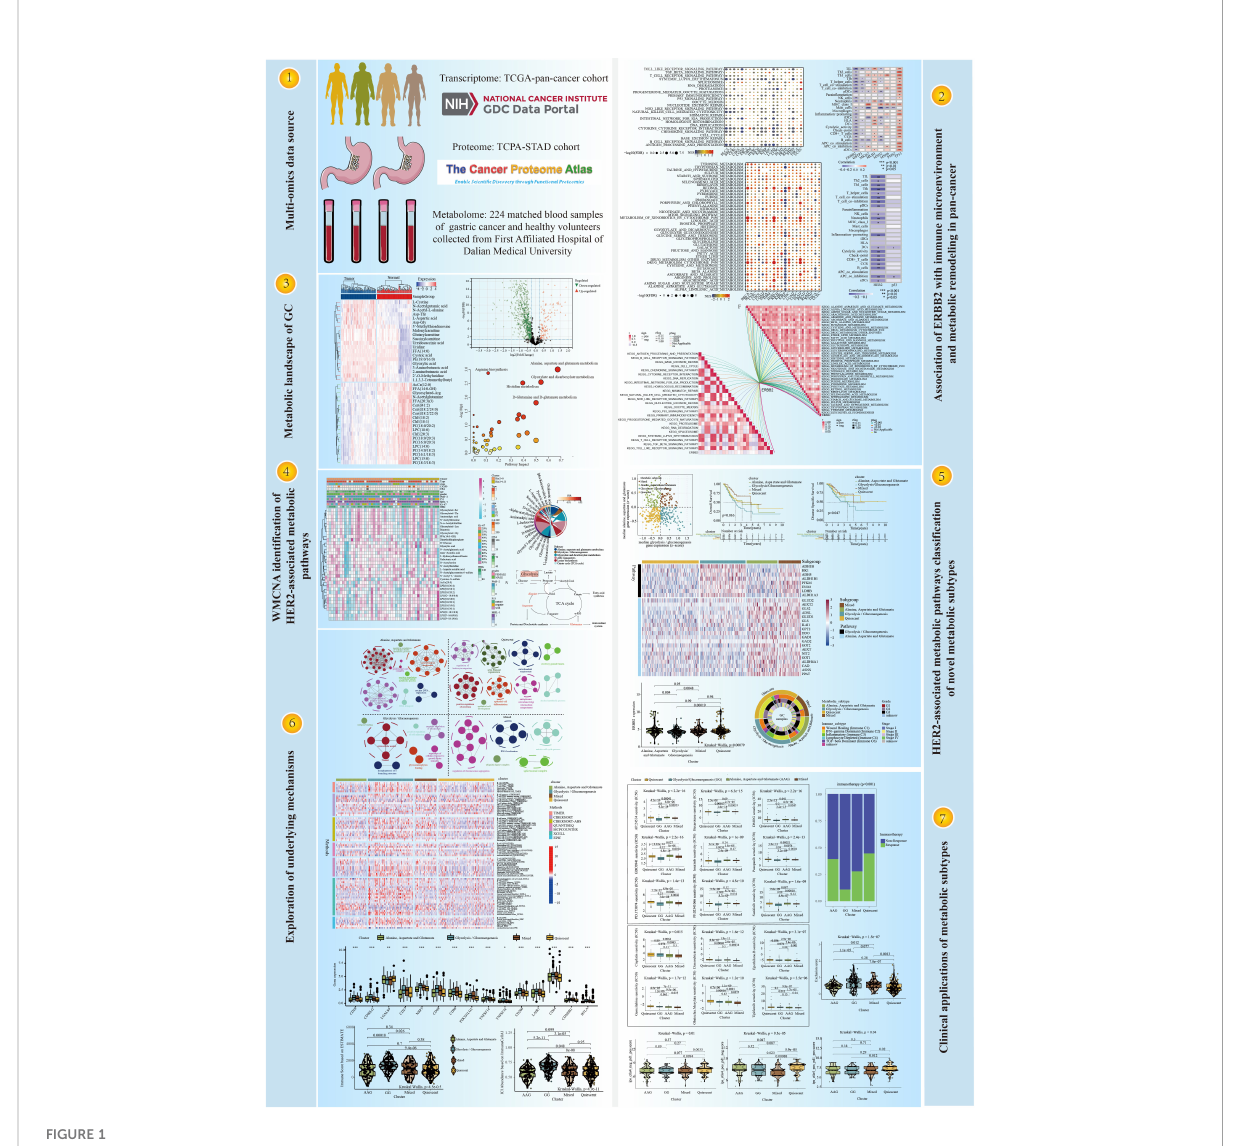
FIGURE 1 The work fl ow of this